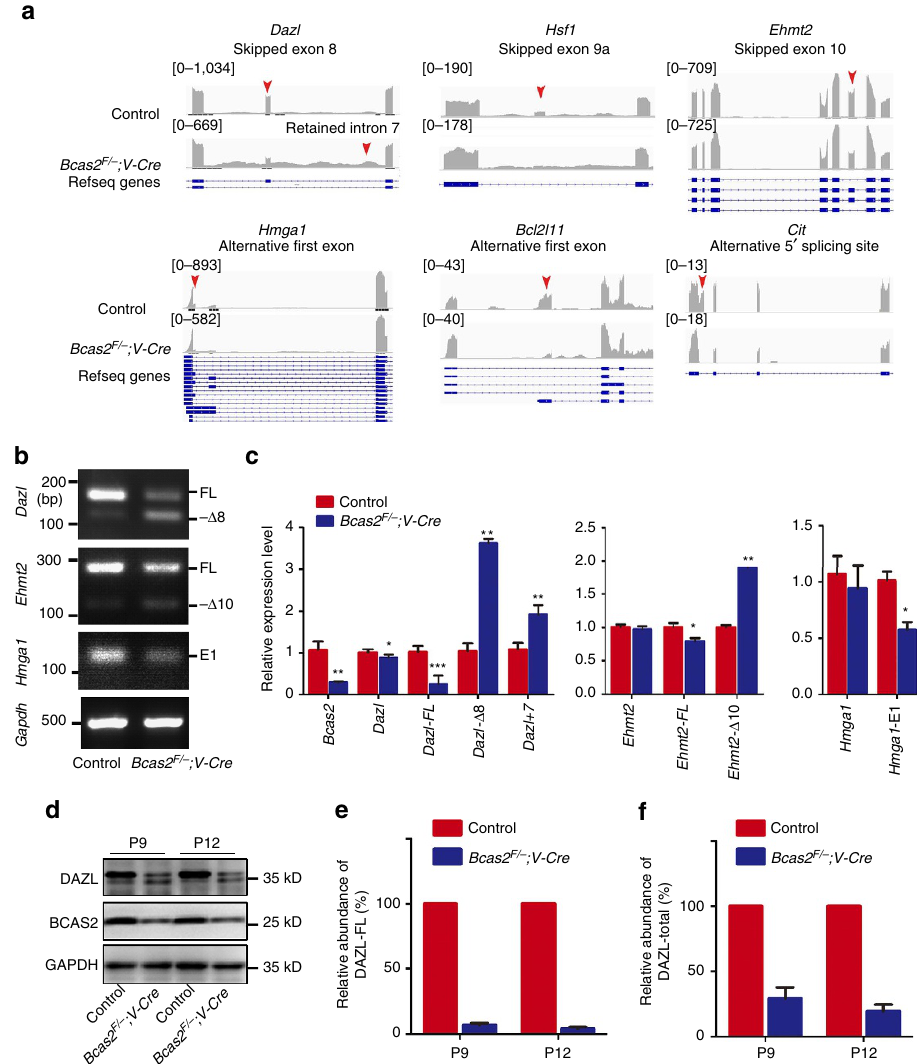
Figure 6 | Bcas2 is involved in pre-mRNA splicing of functional genes during spermatogenesis. ( a ) RNA-seq results of alternative sites in genes related to spermatogenesis using IGV software. Red arrowheads indicate splicing sites. ( b ) RT-PCR analysis of alterative splicing patterns of the changed splicing genes in control and Bcas2 F/ (cid:2) ;Vasa-Cre testes of P9 mice with Gapdh as the internal control. RT-PCR was performed with specific primers (Supplementary Table 6) in three independent experiments. ( c ) Real-time RT-RCR verified the changed splicing genes with Hprt as the internal control. Dazl- FL and Ehmt2 -FL represent the full-length isoform and Dazl - D 8 and Ehmt2 - D 10 denote the short form that lacked exon 8 and exon 10, respectively. An alternative first exon of Hmga1 was shown by Hmga1 -E1. Dazl þ 7 primers specifically recognized intron 7 of Dazl . Dazl , Ehmt2 and Hmga1 were detected using primers at the common region (except for the splicing site) of both isoforms (* P o 0.05; ** P o 0.01; *** P o 0.001, n 4 5). Error bars represent s.e.m. ( d ) Western blotting analysis of the expression of two isoforms of DAZL in control and Bcas2 F/ (cid:2) ;Vasa-Cre testes of P9 and P12 mice with GAPDH as the loading control. ( e and f ) Relative abundances of DAZL-FL ( e ) and DAZL-total ( f ) in control and Bcas2 F/ (cid:2) ;Vasa-Cre testes from P9 and P12 mice were determined by Western blotting analyses of four independent experiments. Error bars represent